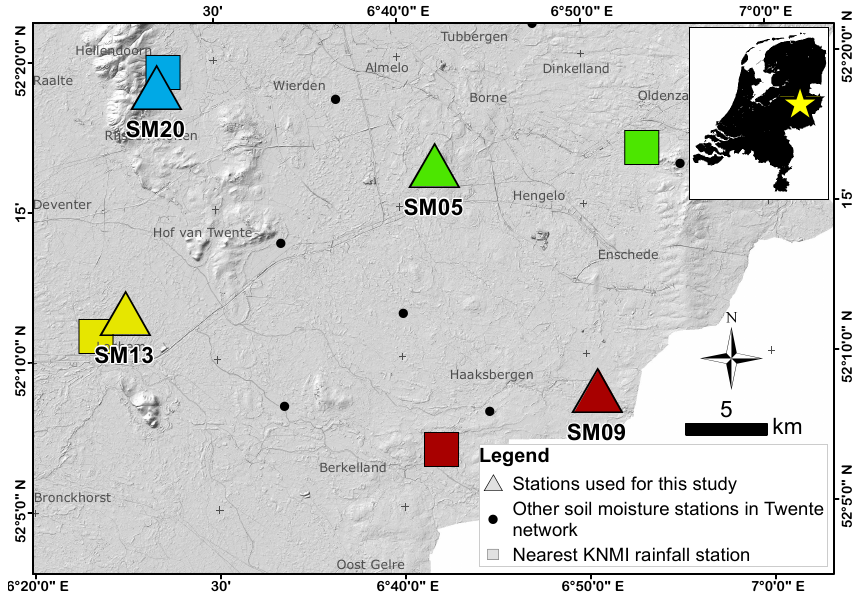
Figure 1. Location of study site in the eastern part of the Netherlands (inset). Triangles represent stations used within the Twente soil moisture and temperature monitoring network (Dente et al., 2011). Squares represent meteorological stations. Symbols with similar colors indicate the pair of measurements used for the analysis.